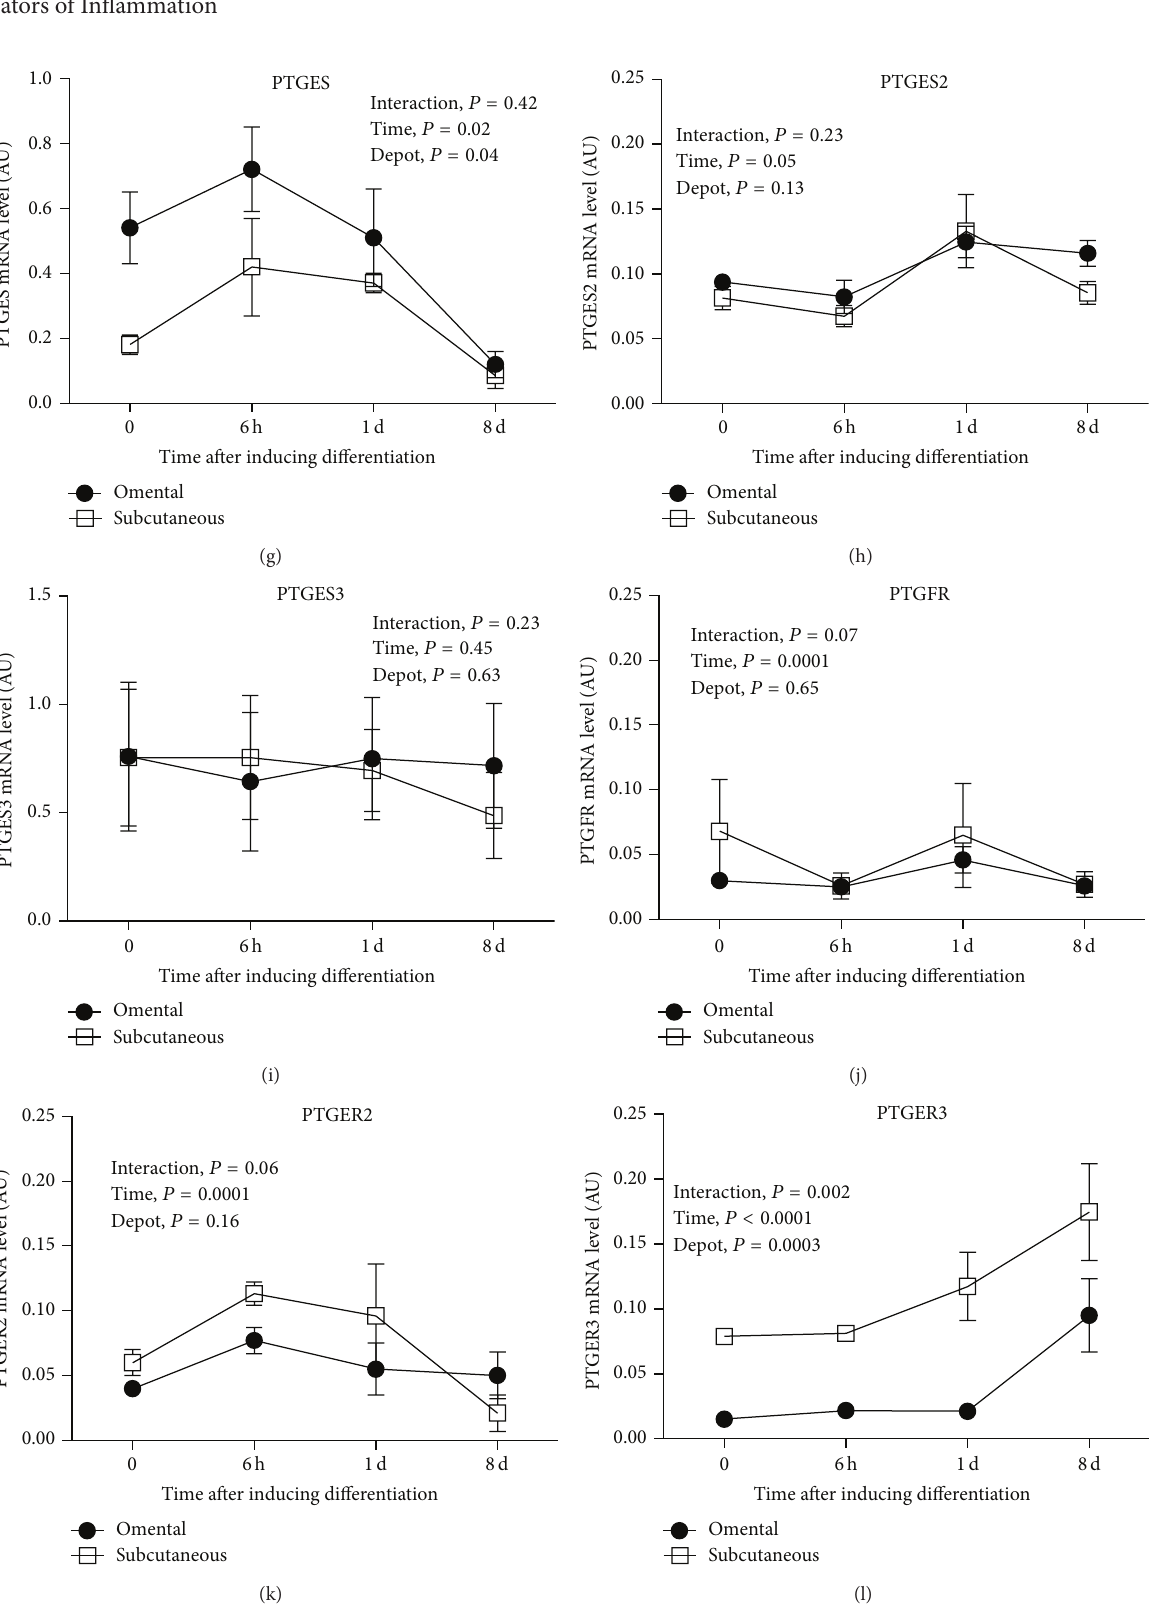
Figure 5: (a) PLA2G16, (b) COX-1 (PTGS1), (c) COX-2 (PTGS2), (d) AKR1B1, (e) PTGDS, (f) PTGIS, (g) PTGES, (h) PTGES2, (i) PTGES3 (j) PTGFR, (k) PTGER2, and (l) PTGER3 mRNA expression during omental ( 𝑛 = 4 ) or subcutaneous ( 𝑛 = 5 ) preadipocyte differentiation (0h, 6h, 1 d, and 8 d). Expression levels relative to G6PD mRNA abundance. Mean ± SEM are shown. All variables were log-transformed to stabilize variances. Reported 𝑃 values are based on transformed values. AU: arbitrary